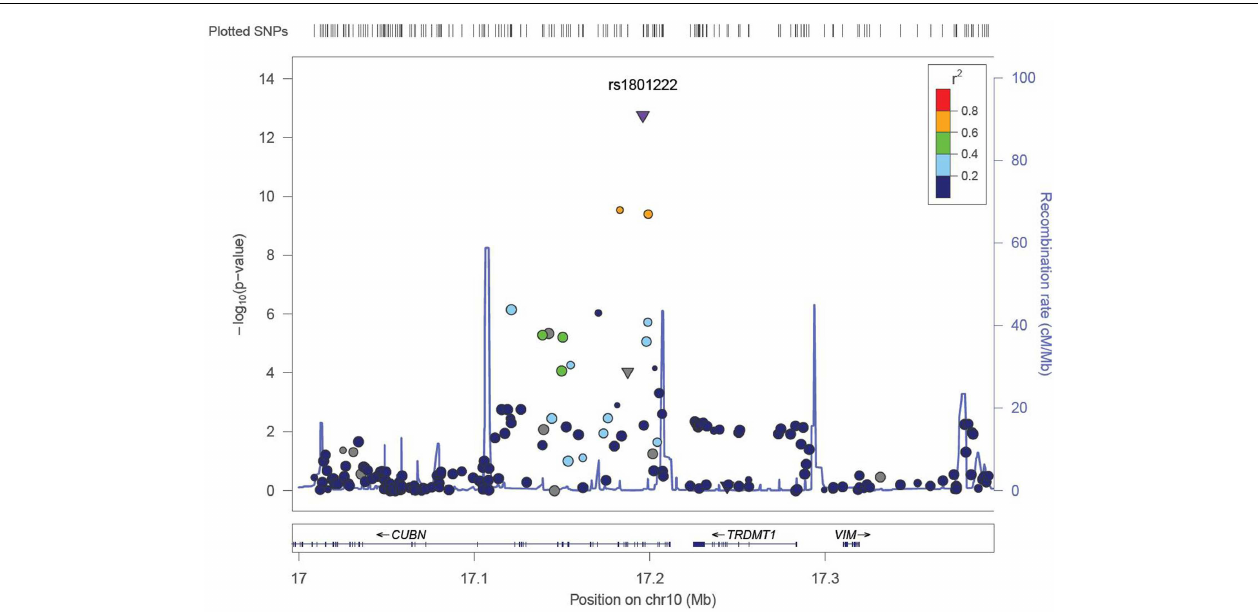
FIGURE 1 | LocusZoom (49) association plot for single SNP associations withVitamin B 12 at the CUBN locus .The SNP position and -LOG ( P -value) are plotted on the X and Y axis, respectively.